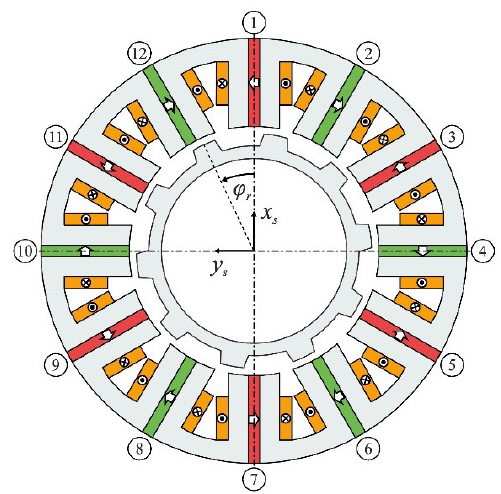
Figure 3. Cross-section of a bearingless flux-switching slice motor with twelve stator teeth and ten rotor poles